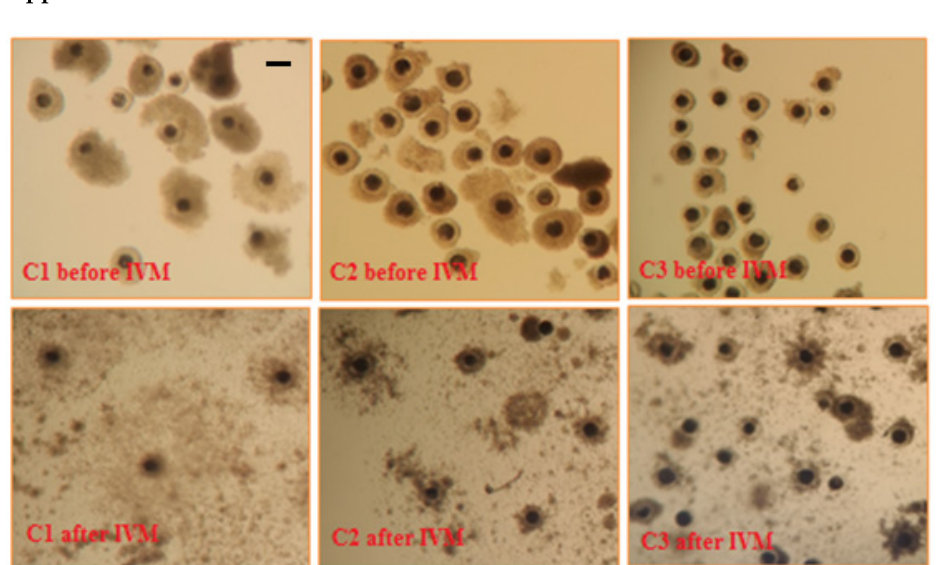
Figure A1. Aspects of porcine oocytes from control group (C) classified according to their morpho- logical aspects (class 1, 2 or 3) before and after IVM. Scale bar represents 100 µm. The scale bar is applicable to all panels (3.2X).